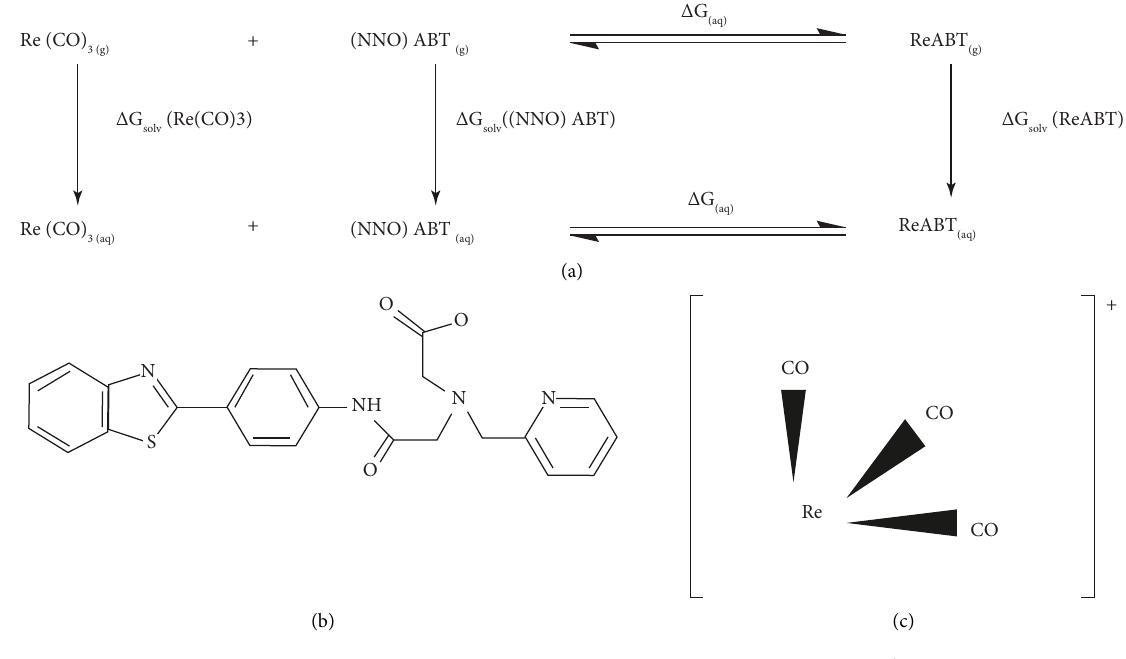
Figure 2: (a) Termodynamic cycle. (b) (NNO) ABT. (c) Re(CO) 3+ .